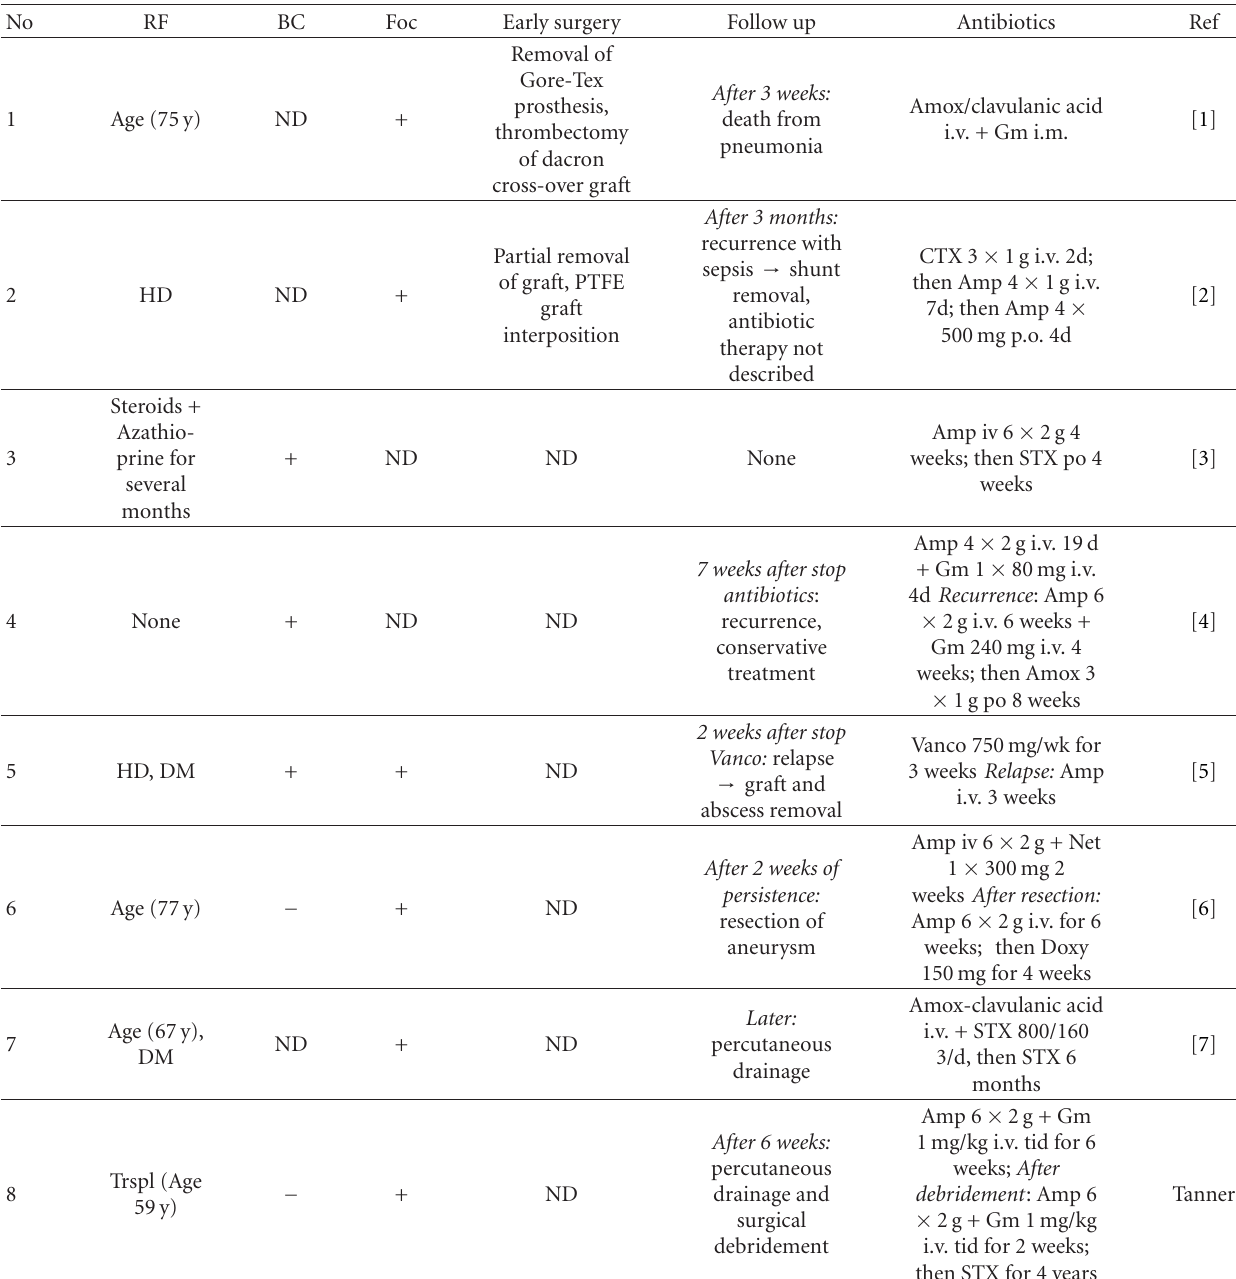
Table 1: Summary of the 8 so-far reported graft infections due to Listeria monocytogenes